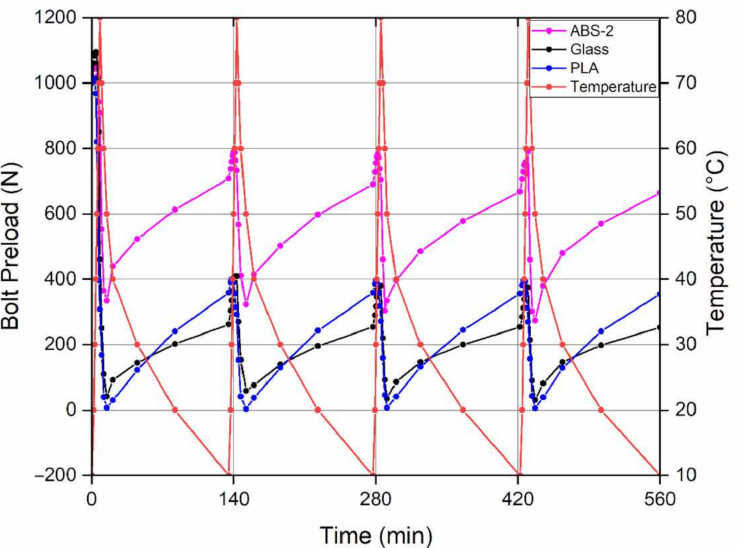
Figure 5. The preload variations of all bolted joints under cyclical temperature changes from 10 ◦ C to 80 ◦